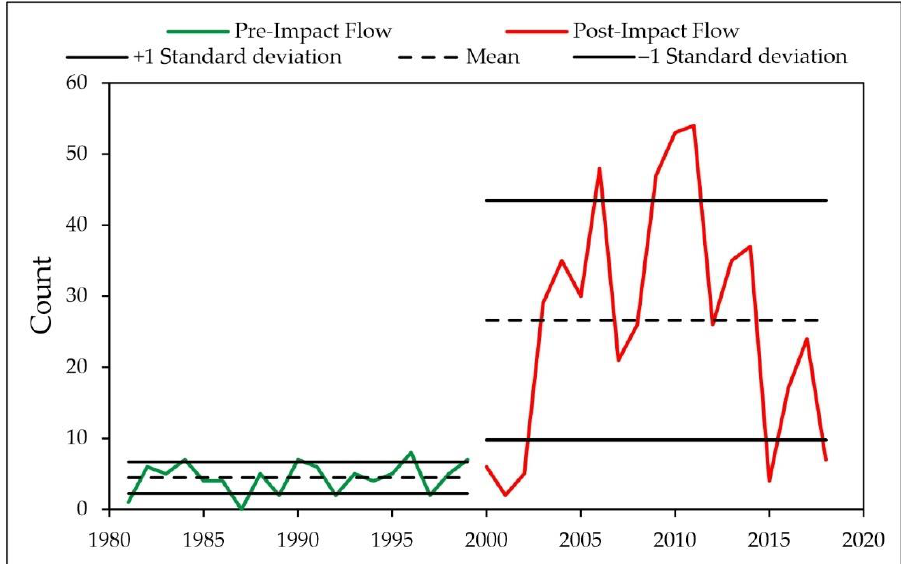
Figure 5. The number of low pulses at Šušvė -Josvainiai WGS before and after construction of Angiriai HPP.